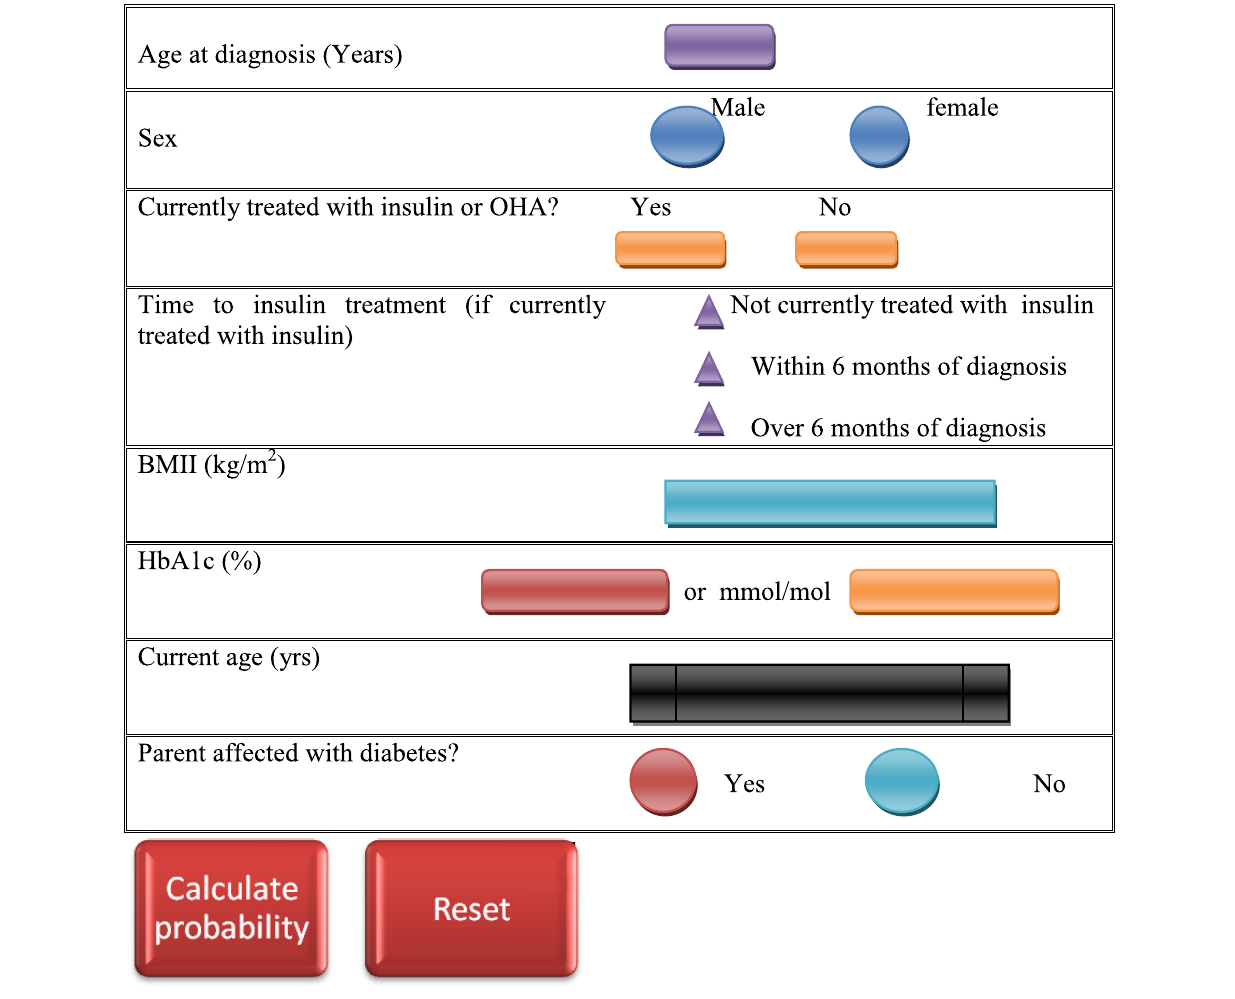
FiGURe 2 | Maturity-onset diabetes of the young (MODY) testing calculator (120). The MODY probability is calculated by entering clinical features of the patient in the probability